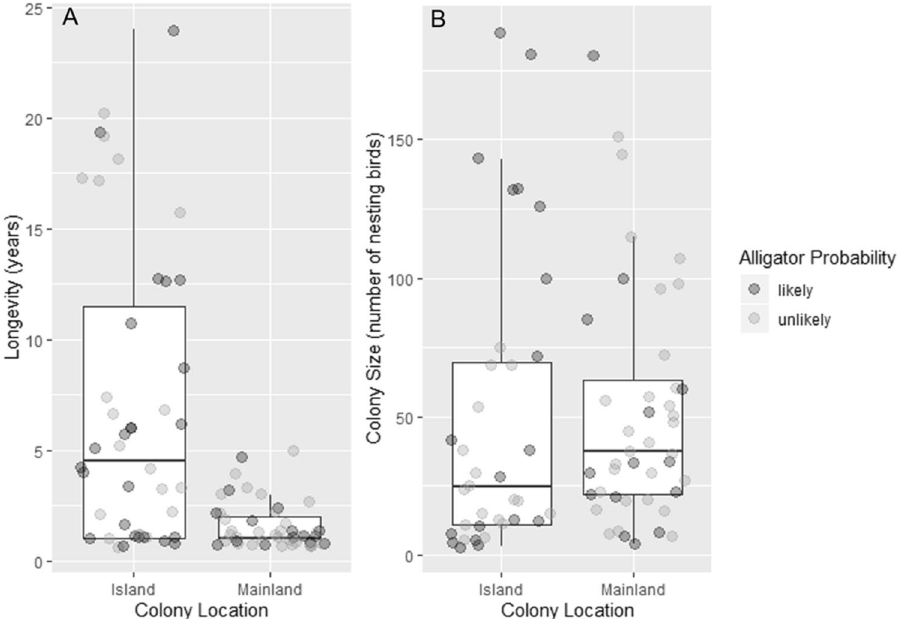
Figure 3. Mainland and island colony characteristics of ( A ) longevity (number of years) and ( B ) colony size (total number of nesting birds) relative to alligator probability. Likely alligator probability is represented by dark circles, unlikely alligator probability is represented by light circles. For boxes, central line shows the median and boxes include all values within the 0.25 and 0.75 quantiles. Whiskers indicate range excluding